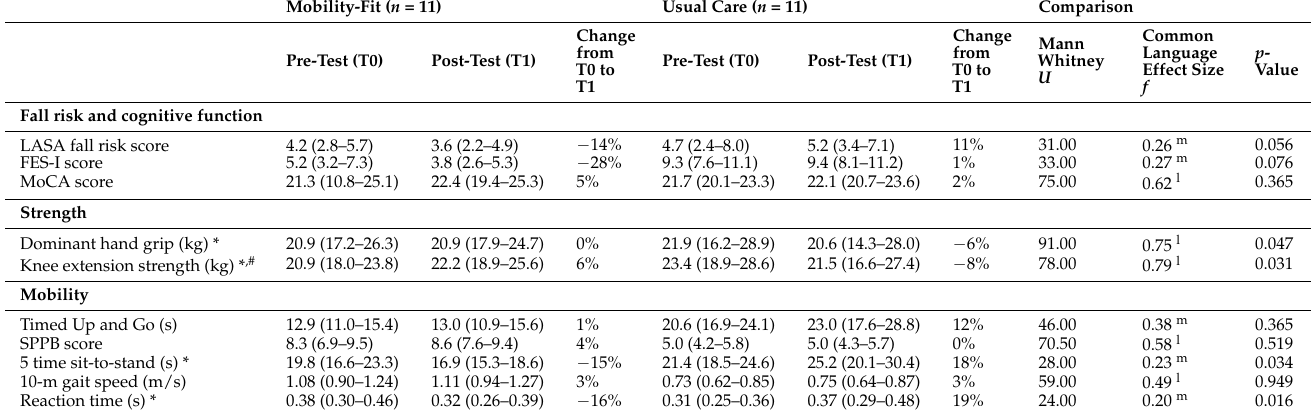
Table 2. Outcome measures bootstrapped mean (bias-corrected and accelerated 95% confidence interval) for Mobility-Fit and Usual Care groups at baseline (T0) and after 12 weeks